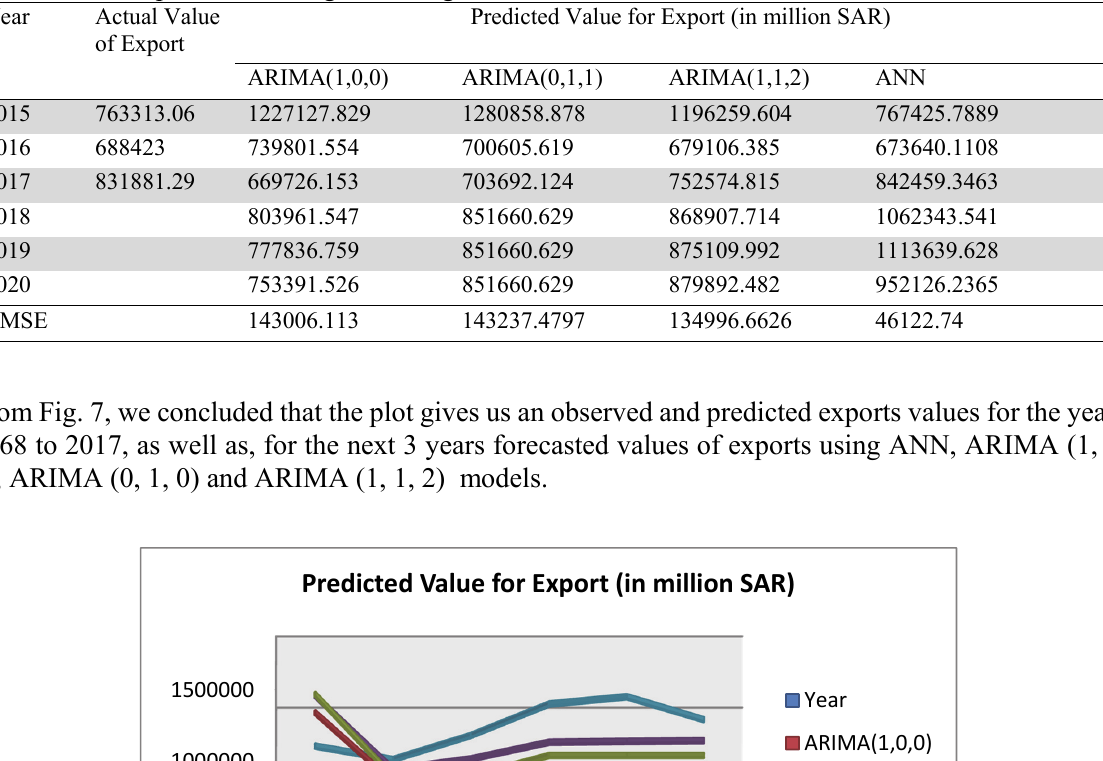
Prediction of Export of the Kingdom using different model